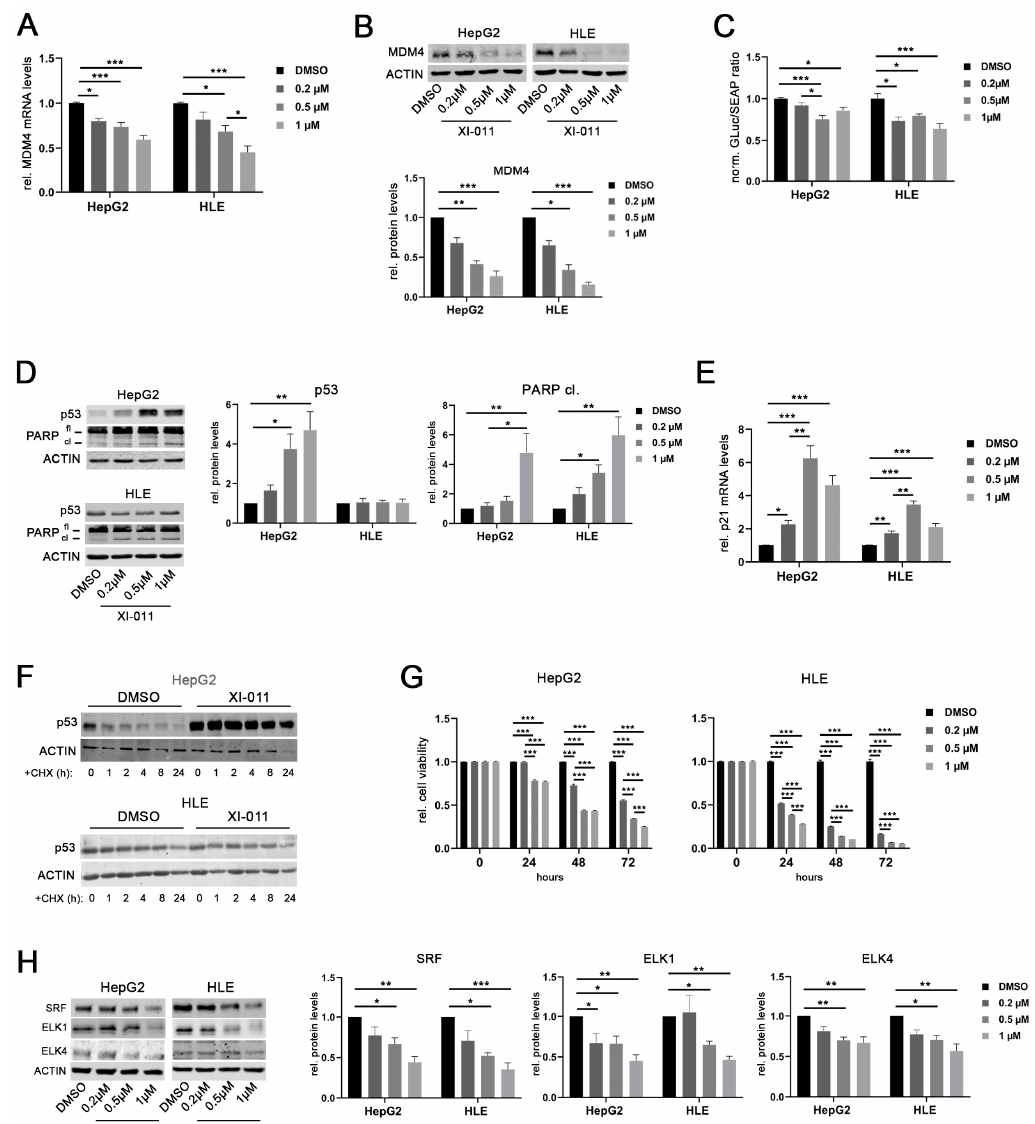
Figure 6. XI-011 inhibits MDM4 transcription by transcription factor downregulation. ( A ) MDM4 mRNA level at 16 h following XI-011 treatment of HepG2 and HLE cells. ( B ) MDM4 protein expression as detected by Western immunoblots and corresponding densitometric analysis (lower panel) 16 h following XI-011 treatment of HepG2 and HLE cell